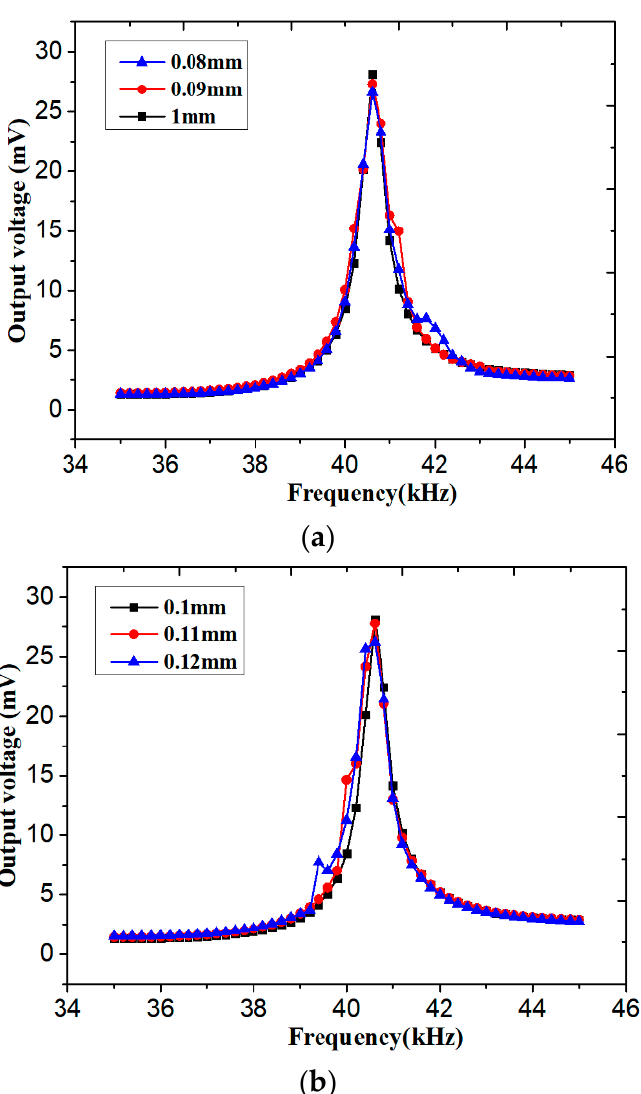
Figure 8. The output voltage with different ln2 values: ( a ) less than 0.1 and ( b ) more than 0.1.